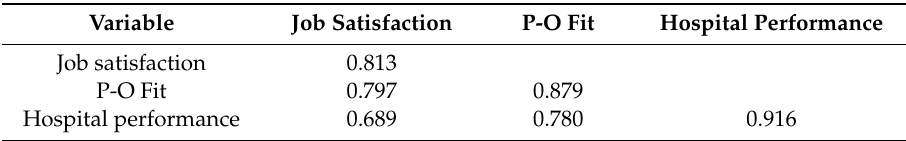
Table A2. Square root of AVE and Pearson correlation coe ffi cients of the measurement scales(two items deleted from job satisfaction